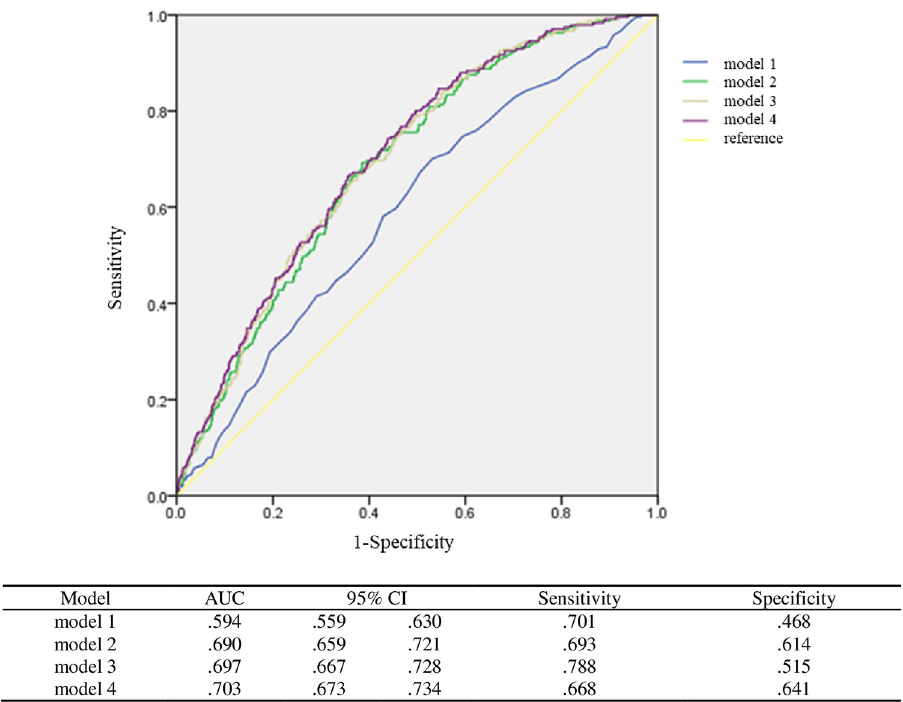
Fig 1. Receiver Operating Characteristic curve (ROC curve) of model 1 to 4. Model 1 = Unadjusted. Model 2 = Model 1 + age, gender. Model 3 = Model 2 + serum LDL, serum creatinine, AST, serum albumin, serum Na, HsCRP. Model 4 = Model 3 + smoking, alcohol consumption, exercise habits.